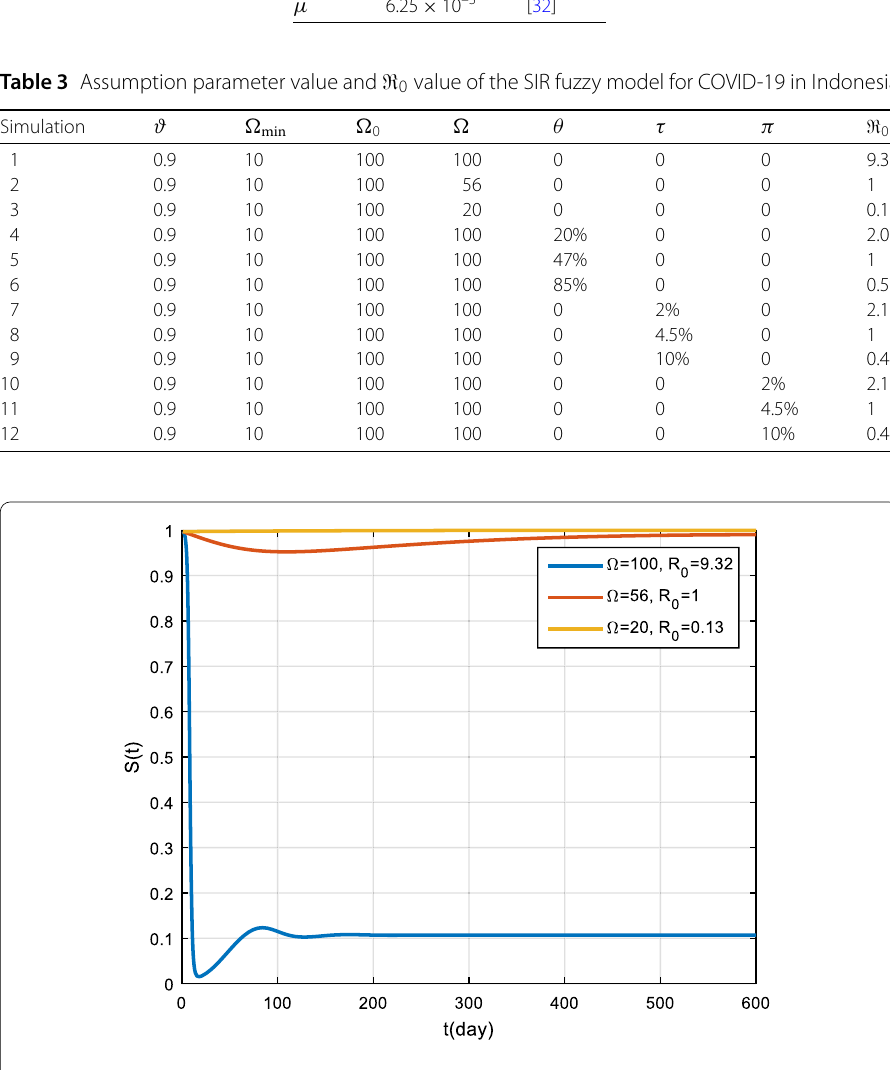
Figure 5 Variation in the number of suspected population for different values of